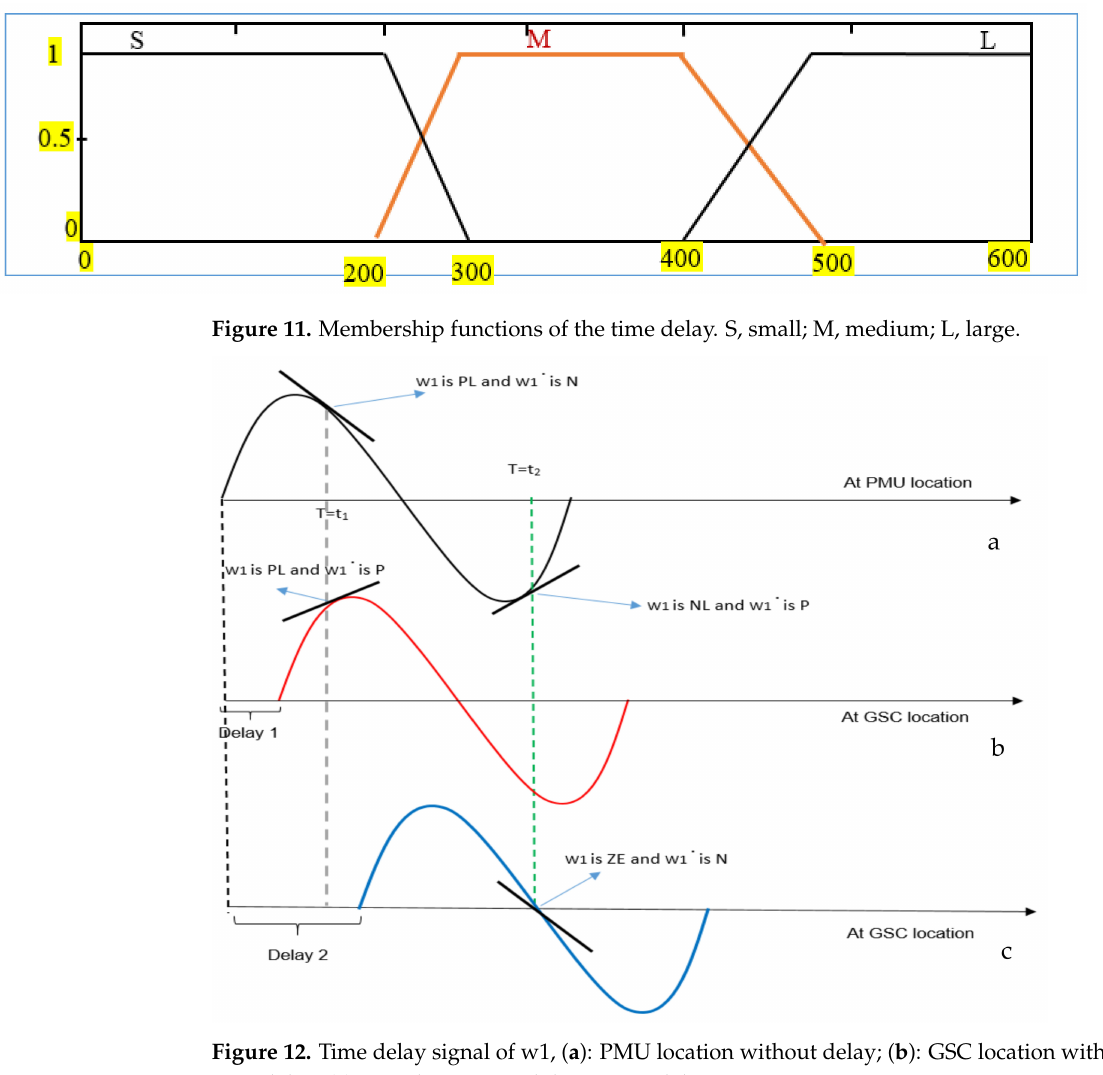
Figure 10. SSR oscillation in synchronous generation with a wide-area fuzzy controller have a delay of 350 ms.